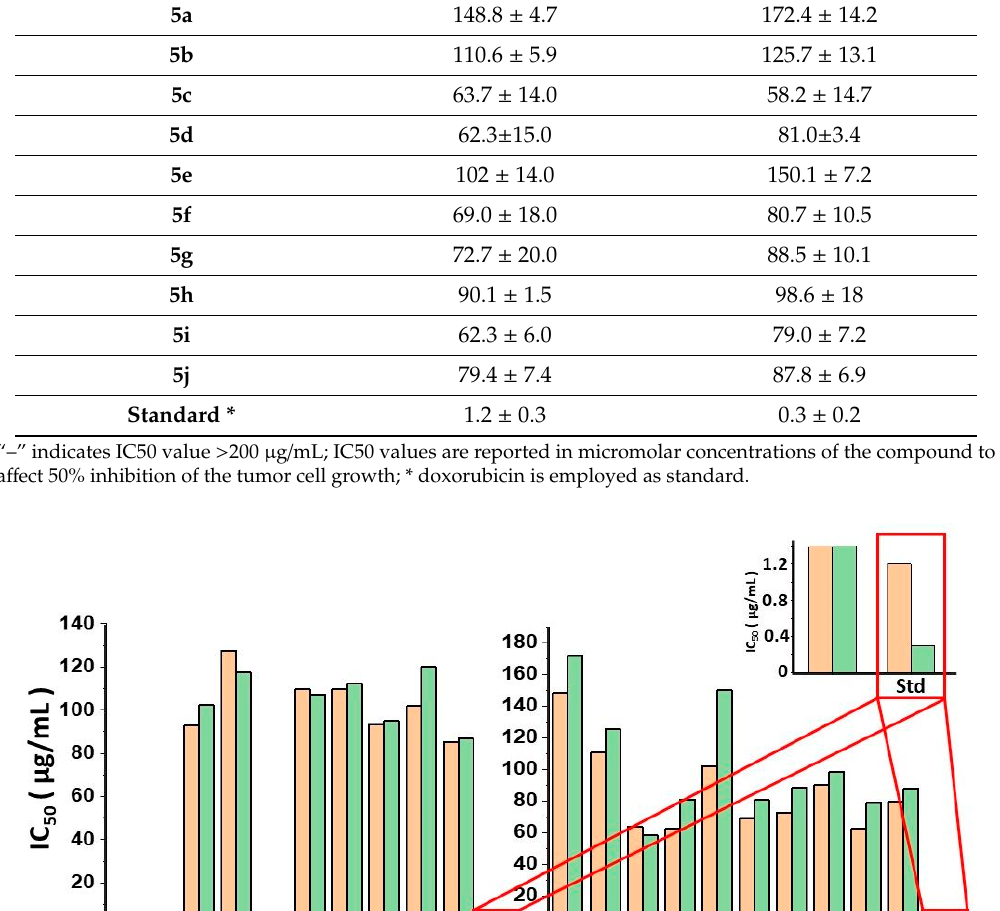
Table 4. Anticancer activity of compounds 5a–5j.